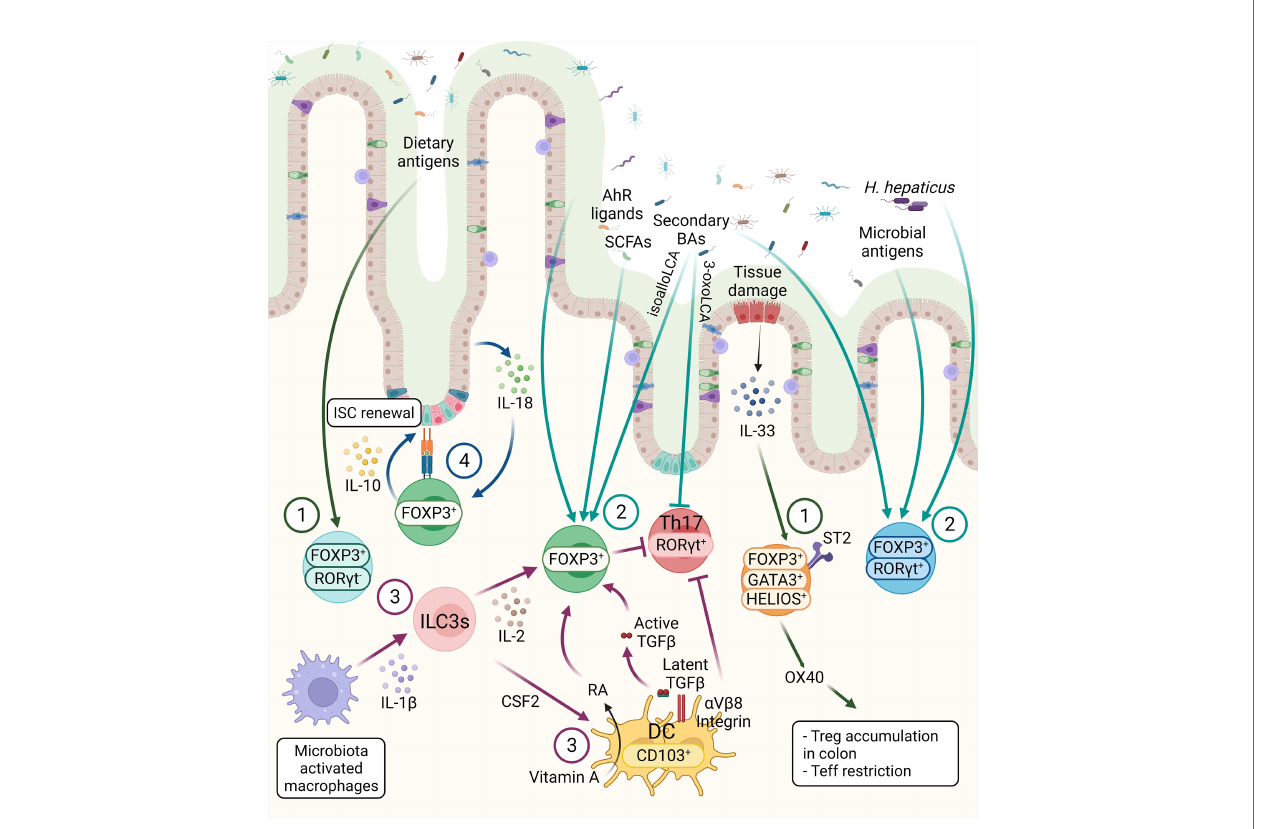
FIGURE 2 | The three main subsets of FOXP3 + Tregs are controlled by host and environmental factors in the intestine. 1) The FOXP3 + ROR g t - Tregs are present mainly in the small intestine, mainly induced by dietary antigens. GATA3 + Tregs are thymic origin Tregs with high level of ST2, thus these cells can respond to IL-33, secreted from IECs in response to tissue damage. Moreover, OX40 expression on GATA3 + Tregs supports the accumulation of Tregs in the colon and OX40 is required for the Tregs-mediated restriction of effector T cells (Teff). 2) ROR g t + Tregs constitute the main colonic Tregs subset, promoted by the microbiota. SCFAs, secondary BAs and AhR ligands can induce Tregs differentiation, however the effect of these metabolites on different Tregs subsets are not known, except a recent fi nding showing that BAs induce ROR g t + Tregs. 3) CD103 + DCs induce the differentiation of Tregs in a TGF- b -dependent manner and suppress Th17 cells. These functions of DCs are regulated by a V b 8 integrin-mediated activation of latent TGF- b 1 and RALDH-mediated metabolizing of vitamin A into RA. ILC3s, triggered by microbe-activated macrophages, promote Tregs in the intestine through IL-2 or CSF2 production. These microbiota induced Tregs, either through microbial metabolites or other immune cell types are essential for the maintenance of immune homeostasis. 4) The crosstalk between intestinal epithelium and Tregs are essential for intestinal homeostasis. Tregs can interact directly with ISCs via MHCII molecule and promote ISCs renewal by IL-10 signaling. IECs-derived IL-18 is an important regulator of Treg-mediated suppression of intestinal in fl